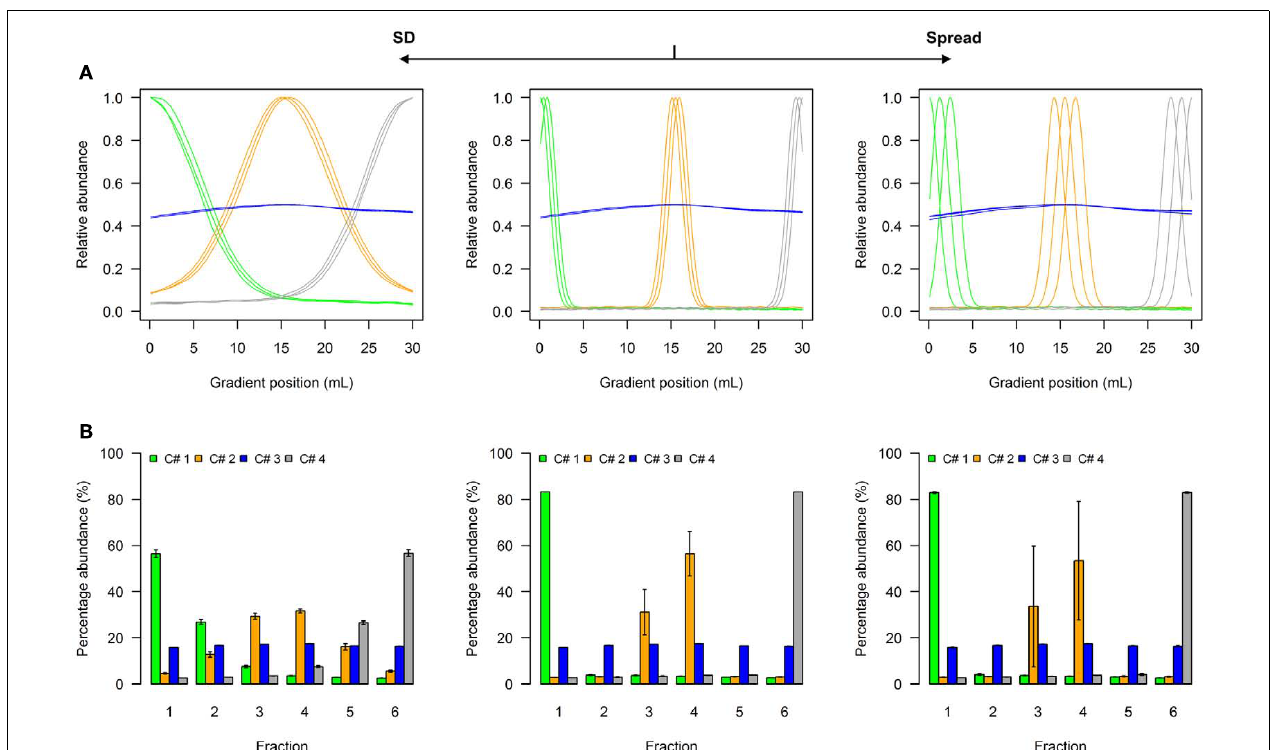
compartment-specific markers for each compartment after the continuous distributions were discretized into 6 equally spaced fractions.The left–side graph illustrates the effect of increasing the SD (SD = 5, ms = 0.4), while the right-side graph shows the effect of increasing the marker spread ms (SD = 1, ms = 1.2) compared to a standard (middle graph with SD = 1, ms =